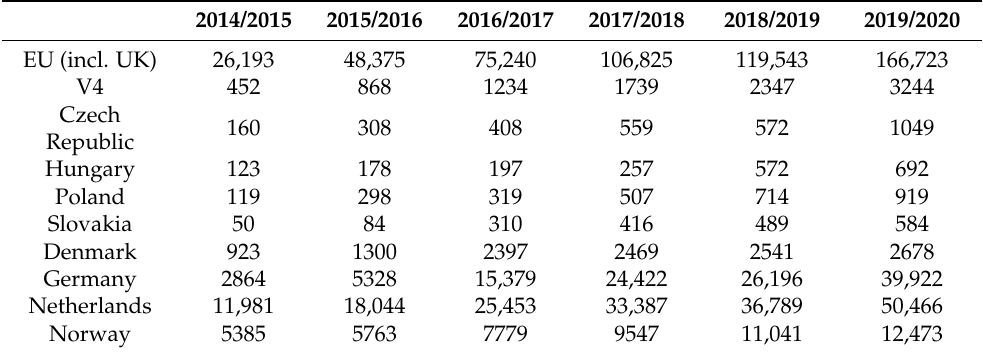
Table 3. The total number of charging stations at the turn of the years, (source: elaborated by authors based on [25]).